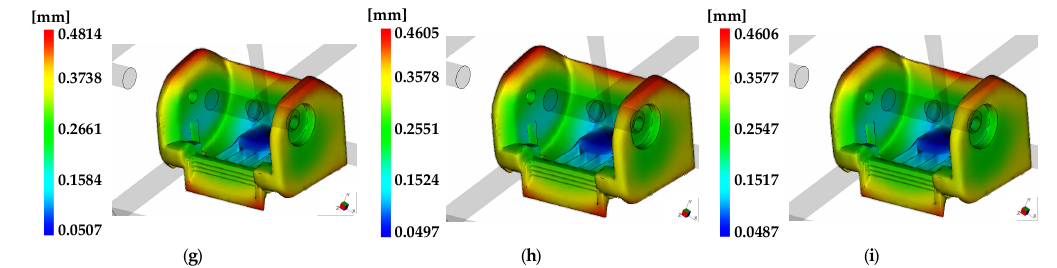
Figure 8. Deflection for the pivot sub-assembly. ( a ) Case 1. ( b ) Case 2. ( c ) Case 3. ( d ) Case 4. ( e ) Case 5. ( f ) Case 6. ( g ) Case 7. ( h ) Case 8. ( i ) Case 9.